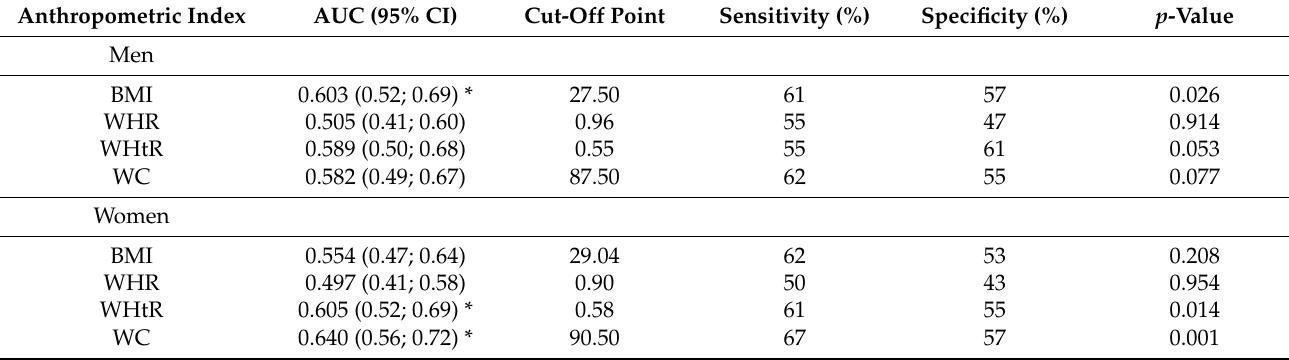
Table 4. The area under the ROC curve (AUC) to predict hypertension among men and women.